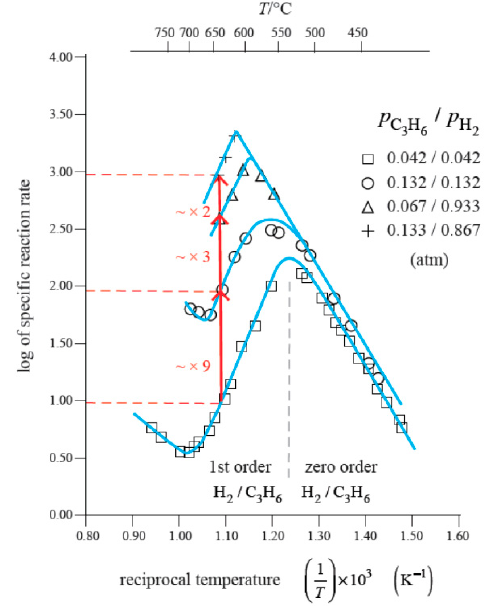
Figure 4. Nucleation and growth of an initial graphene layer on a Ni (111) nanoparticle surface. The graphene layer growth at the borders goes on by bending down. Six pentagons must form at six corners, in a perfect hexagon, or differently when the flat crystal face is oval. Example shown: Two pentagons form in the row, reaching the border earlier ( P ) and four pentagons in next row ( P ′ ).